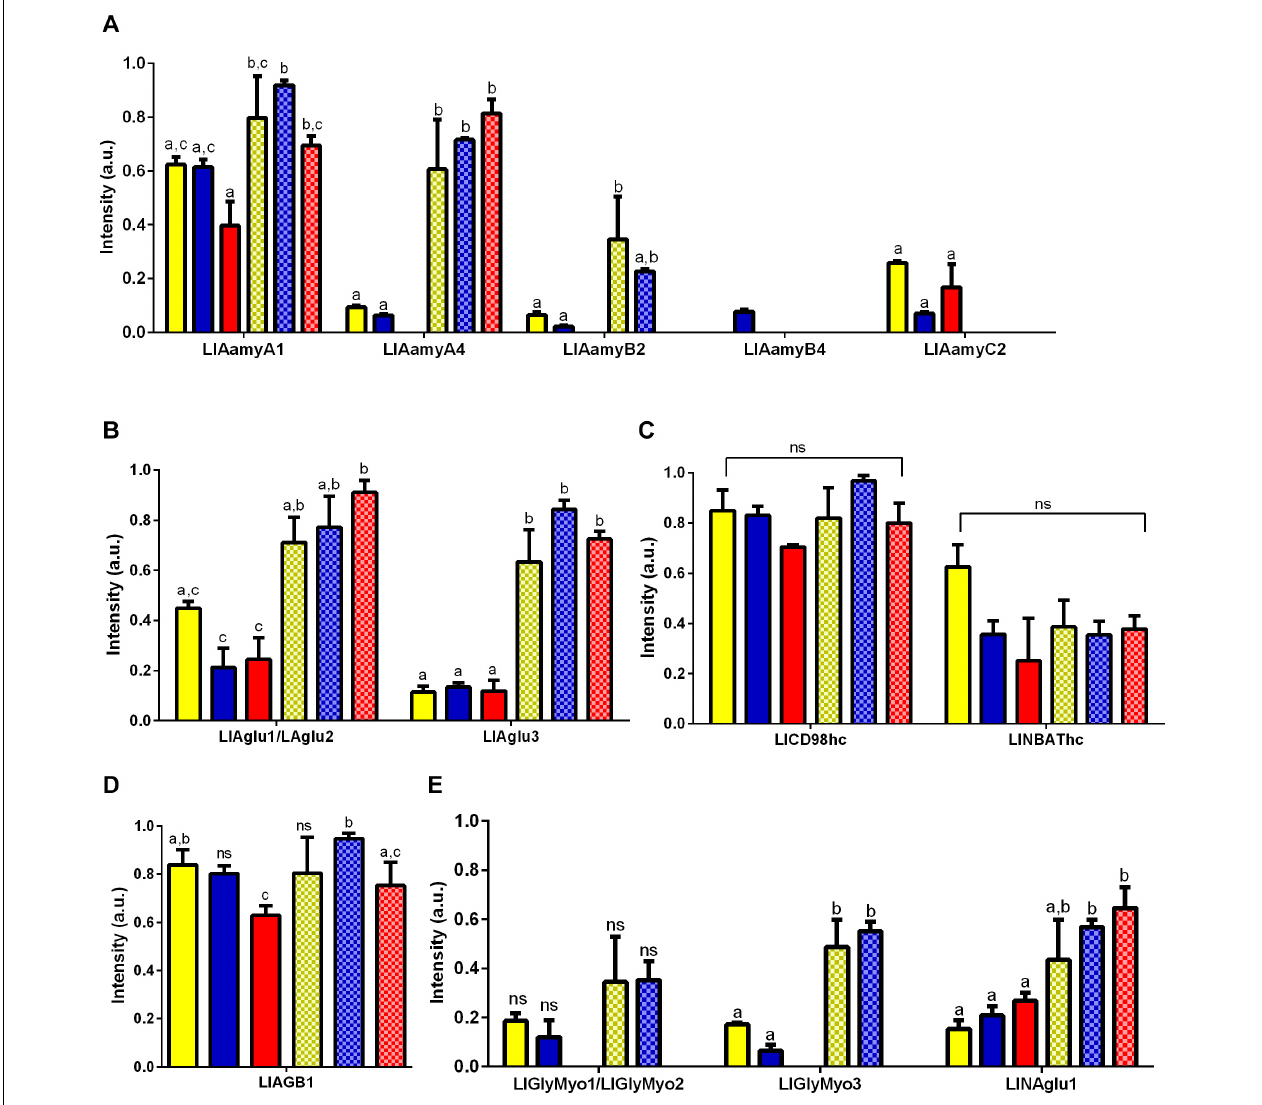
FIGURE 4 | Expression pattern of genes belonging to GH13 and GH31 families in L. longipalpis by RT-PCR. Expression was analyzed in different tissues of females submitted to different physiological conditions. The expression of genes from GH13 was analyzed for (A) α -amylases (LlAamyA1, LlAamyA4, LlAamyB2, LlAamyB4 and LlAamyC2); (B) α -glucosidases (LlAglu1/LlAglu2 and LlAglu3); (C) amino acid transport proteins heavy chain (LlCD98hc and LlNBAThc); (D) 1,4-glucan-branching enzyme (LlAGB1). For the GH31, the expression pattern was analyzed for (E) glycosidases NET37 (LlGlyMyo1/LlGlyMyo2 and LlGlyMyo3) and neutral alpha-glucosidase (LlNAglu1). Samples of the rest of the body (plain bars) and gut (dotted bars) were analyzed for each physiological condition tested; newly hatched females (yellow bars), females fed on 1.2 M sucrose for 48 h (blue bars) and females after 48 h of blood-feeding (red bars). Results were the mean ± SEM of three biological replicates. Each replicate included two cDNA samples for each condition tested. cDNA samples were obtained from a pool of 10 sand flies (gut or rest of the body). One-way ANOVA, followed by Tukey multiple comparison tests. In the subset of results for each gene, bars with the same letters are not statistically different to each other, p > 0.05. ns: results with no significant differences to the other bars of the